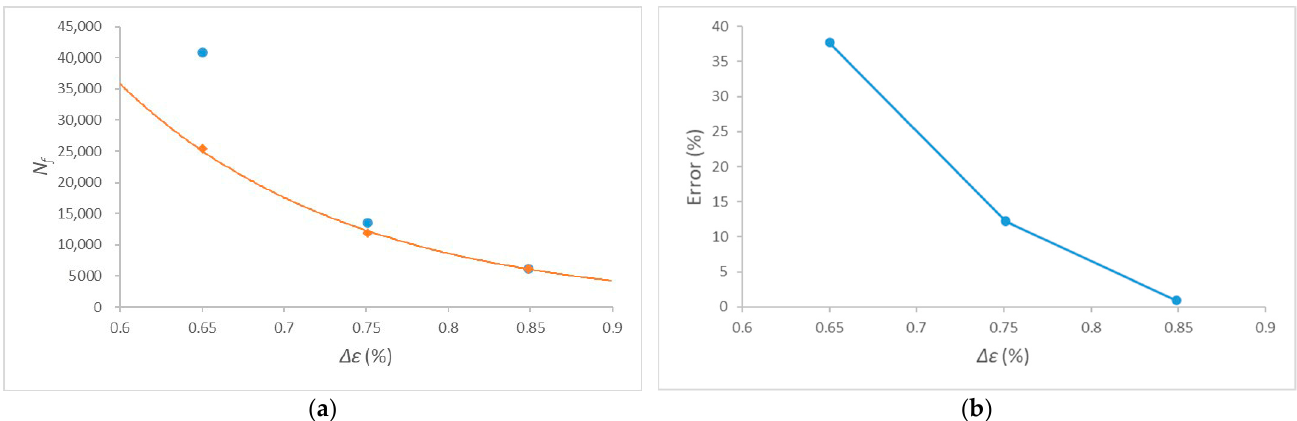
Figure 9. Life prediction of non-destructive specimens with R = 0.2: ( a ) Fatigue life prediction curve ( b ) Fatigue life prediction error.